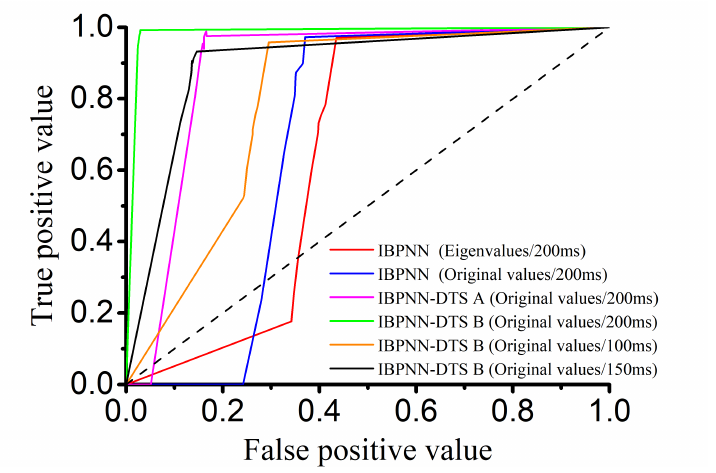
Figure 7. ROC curve of different models with different input (dashed line indicates completely random classification).